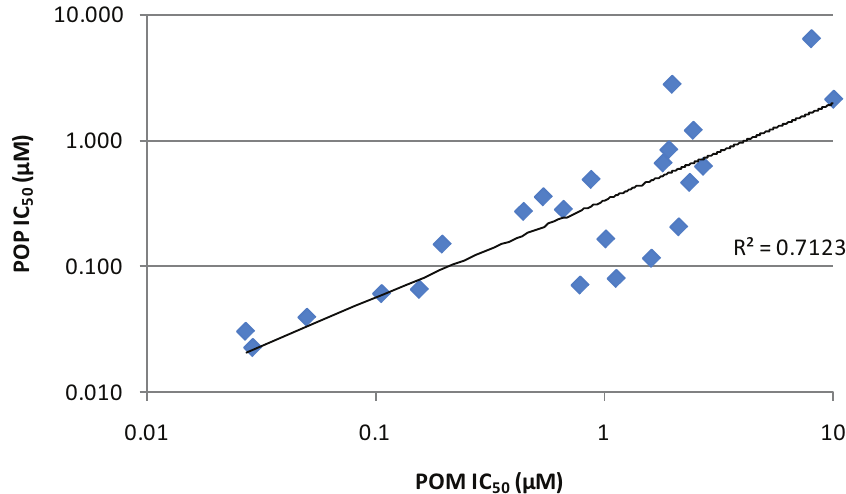
Supplementary Figure 2. Correlation of POM and POP IC mean of at least two independent